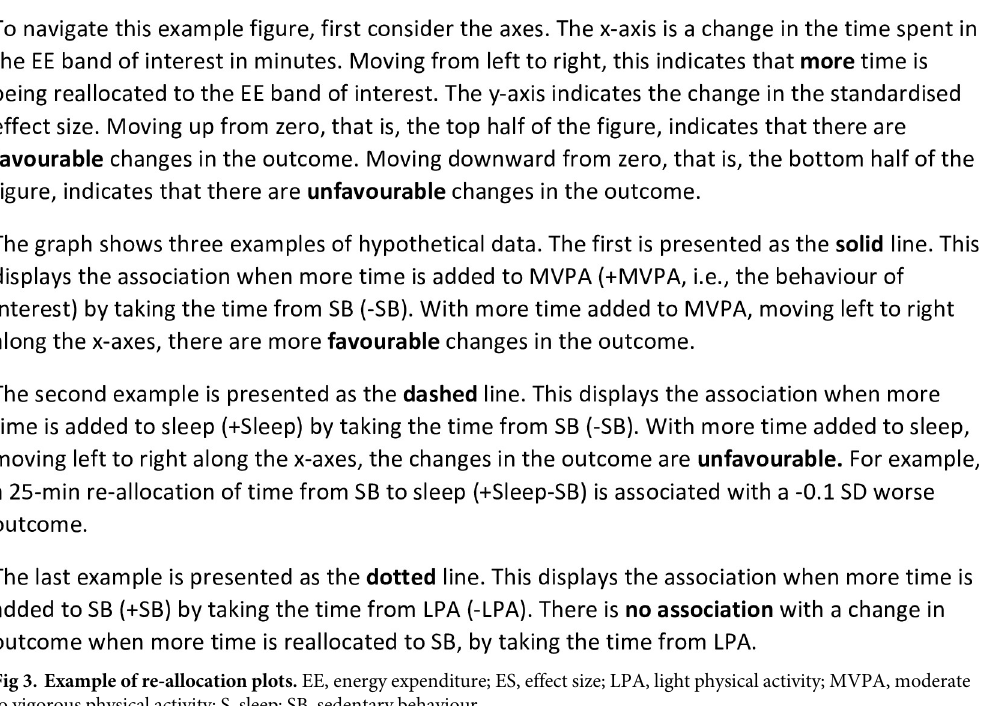
PLOS ONE | https://doi.org/10.1371/journal.pone.0214058 March 21,